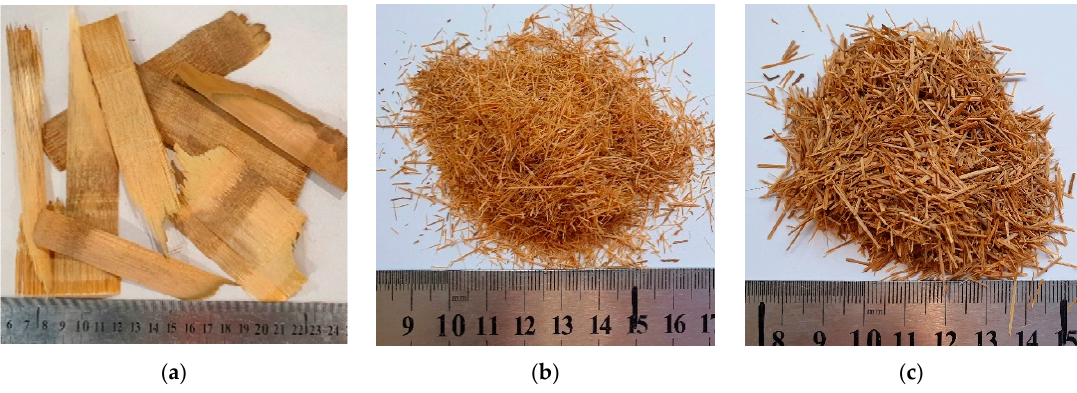
Figure 1. Bamboo fibers. ( a ) Raw waste material; ( b ) 300 µm-diameter fibers after grinding and sieving; and ( c ) 500 µm-diameter fibers after grinding and sieving.